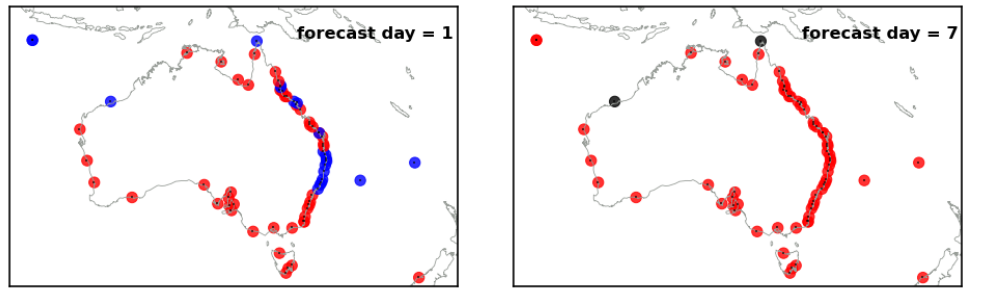
Figure 9. Summary map showing which forecast source provides best information on average with regard to RMS error reduction. Red symbols at locations where aggregated forecast is best, blue for ‘tide + persisted residual’ and black for standard tides. Forecast lead times of 0–24 h are shown in left panel , and 144–168 h on the right panel